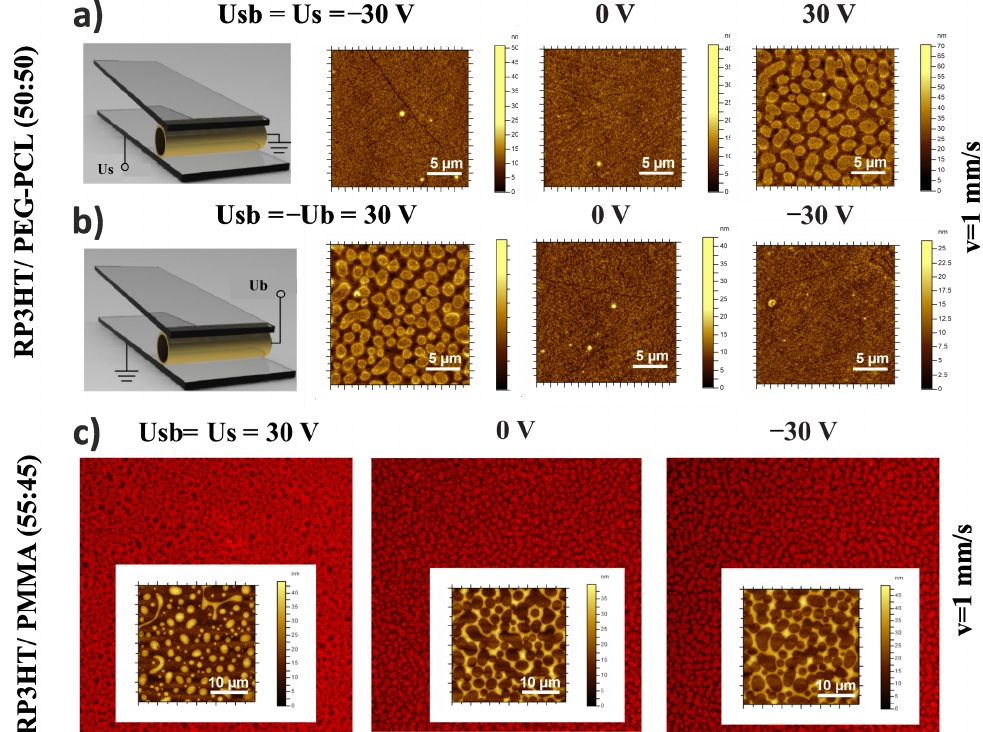
Figure 3. Impact of electric field orientation on the film morphology of H-dip-coated composites: ( a , b ) RP3HT/PEG-PCL (50:50 by weight) and ( c ) RP3HT/PMMA (55:45) electrically switched between the lamellar and lateral structures ( a , b ) and between the phase-inverted droplet-like structures ( c ). AFM height images of the composites coated with the E-field changed between the opposite orientations, with a zero field interval between both regimes, controlled by the voltage Usb ( t ) applied between the substrate and barrier. Equivalent results are obtained for the same Usb values, irrespective of the zero potential being connected to either the barrier ( a ) or the substrate ( b ). ( c ) Fluorescence micrographs of the RP3HT-rich phase revealing the AFM height contrast between the phase-separated domains of RP3HT/PMMA.